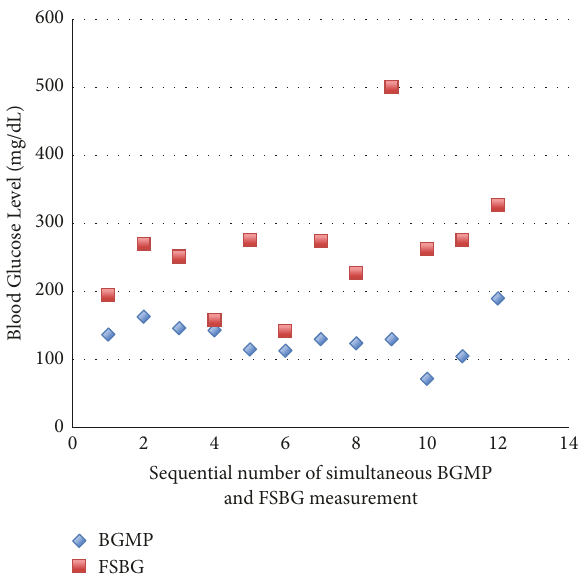
Figure 1: Discrepancy between simultaneous finger stick blood glucose (FSBG) and blood glucose in metabolic panel